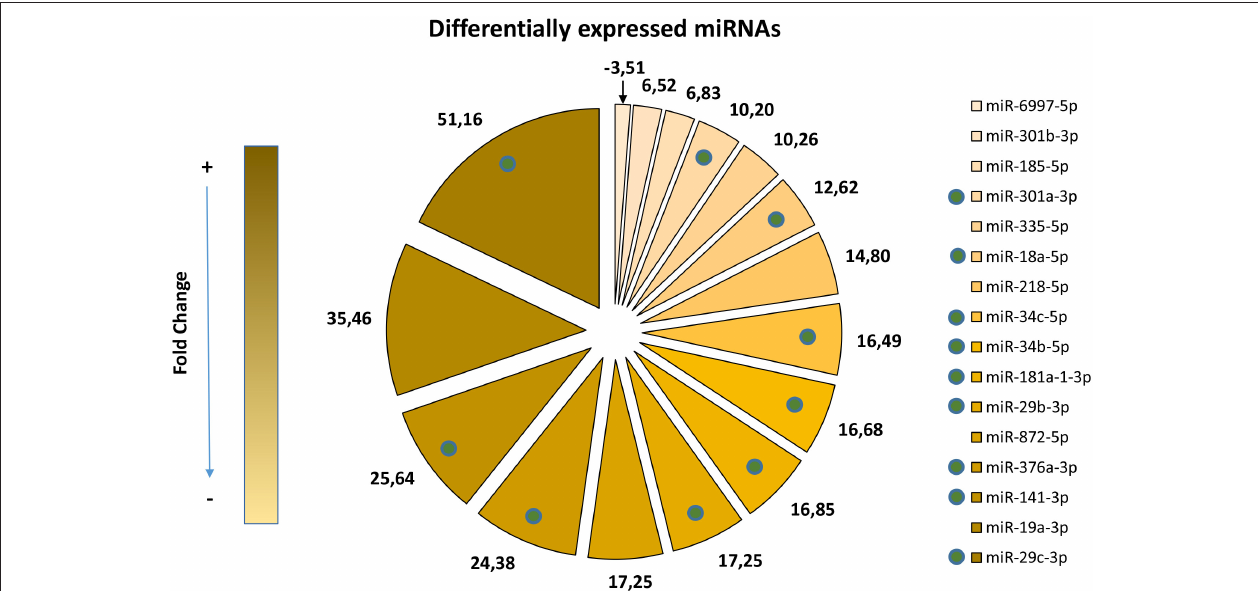
FIGURE 1 | Differentially expressed miRNAs. The pie chart shows significant changes in expression of 16 miRNAs, colored from light to dark gold according to their fold change expression value in Cx30 − / − mice vs. controls with normal Gjb6 alleles ( Cx30 + / + ). The fold change values are shown in clockwise order starting from the smallest one, indicating with an arrow the corresponding pie chart portion. Green tags highlight miRNAs already known as linked to apoptosis or deregulated in the degeneration of the cochlea during aging. Two of these upregulated miRNAs were already found as deregulated in sensorineural diseases of the ear, i.e., miR-18a and miR-376a, in mouse inner ear spatial expression patterns at P0, as previously reviewed ( Ushakov et al., 2013; Mahmoodian sani et al., 2016). Moreover, the upregulation of miR-29b was detected in mouse vestibular sensory epithelium at P2 (Elkan-Miller et al., 2011) and in the degeneration of the mouse OC during aging (at 3m, 9m, and 16m compared to P21) ( Zhang et al., 2013). Four other miRNAs, miR-29c, miR-34c, miR-141, miR-181a, and miR-301a, were previously described as dysregulated in mouse OC with age-related hearing loss (Zhang et al., 2013). In particular, miR-29b/c, miR-34a/c, and miR-181a are reported as pro-apoptotically deregulated in deafness due to aging ( Khanna et al., 2011; Zhang et al.,